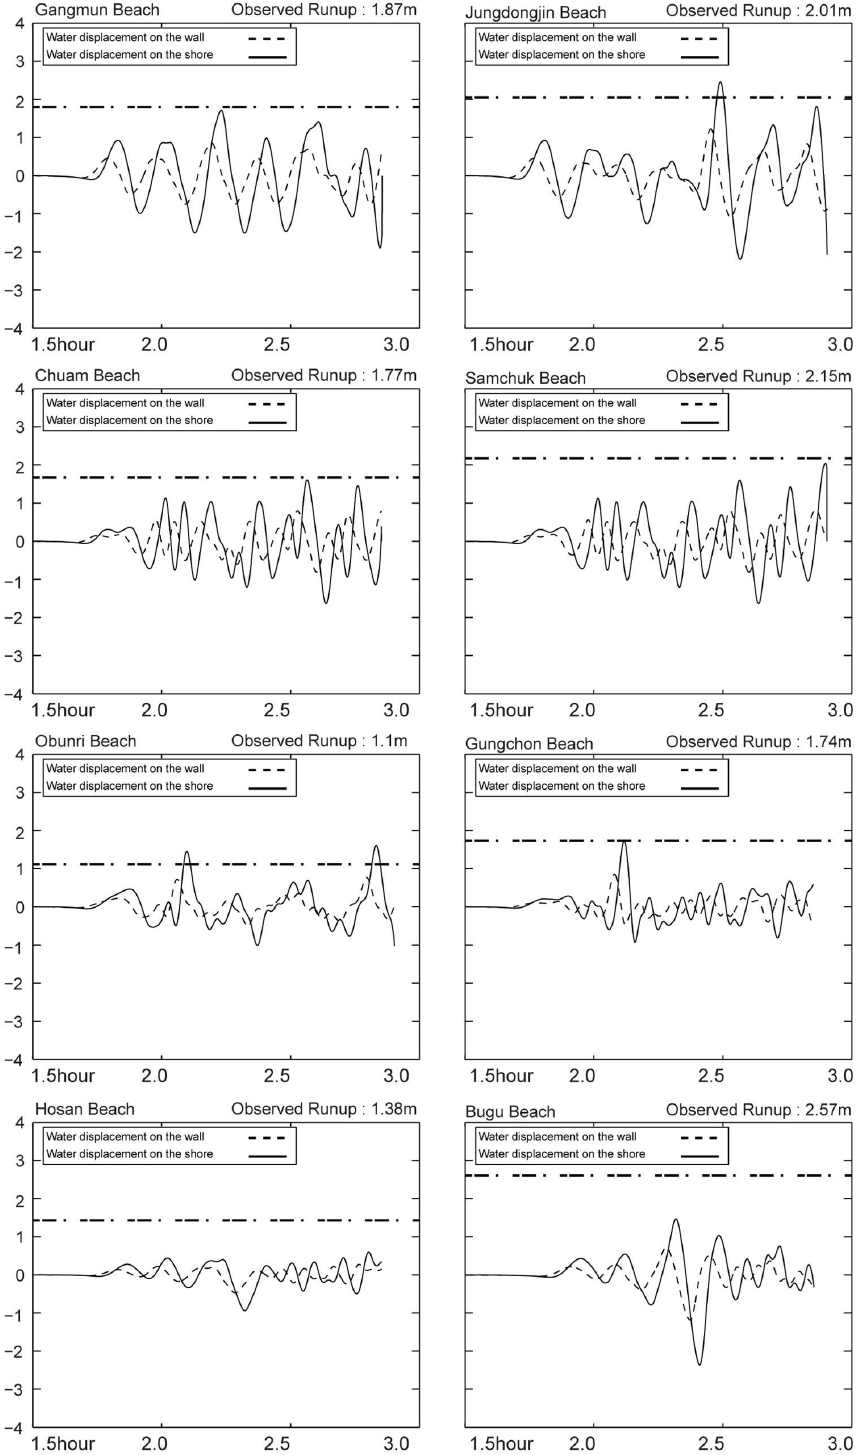
Fig. 5. Computed time series of water displacement on the vertical wall (dashed line) and on shore (solid line). The observed runup heights are shown by a dashed-dotted